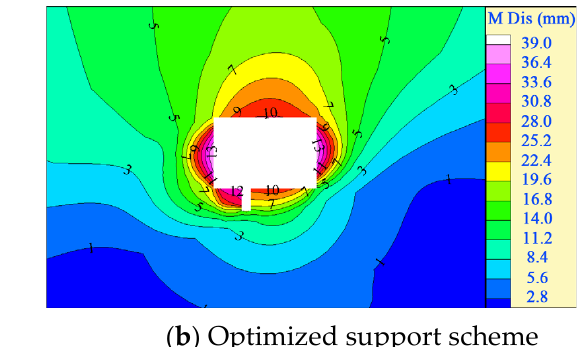
Figure 16. Implementation of the surrounding-rock control technology of the roadway. The original support scheme of the belt grooves of the 2103 working face of the lower coal group of the Wulihu coal industry is as follows. The spacing between the rows is 850 × 900 mm with seven bolts in each row of the top plate. The row spacing between anchor cables is 2000 × 1800 mm with three anchor cables in each row. The row spacing is 850 × 900 mm with five bolts in each row of the side. Left-hand-threaded steel bolts without longitudinal reinforcement are on the forward left side, and full-threaded bolts of glass fiber reinforced plastic are on the forward right side. Two resin anchorage agents